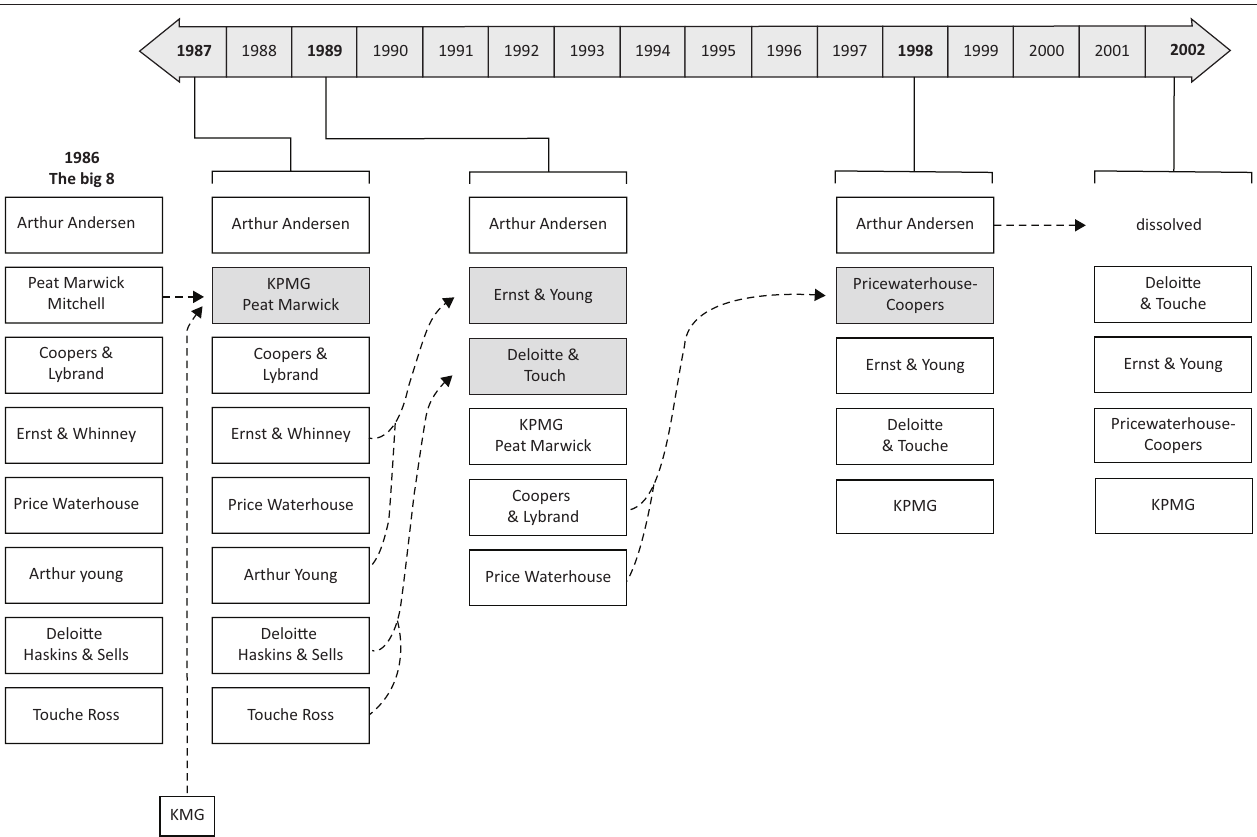
FIG URE 1: 1980s and 1990s: Significant mergers in the audit